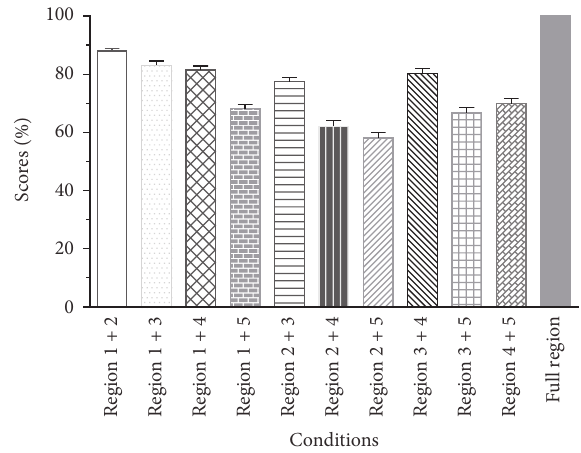
Figure 2: Averaged percent-correct scores for sentence recognition using acoustic temporal envelope as a function of conditions in Group 2 and the condition with a full frequency region in Group 1. The error bars indicate standard errors. Table 2: Comparison of percent-correct scores for conditions with two adjacent frequency regions in two groups.